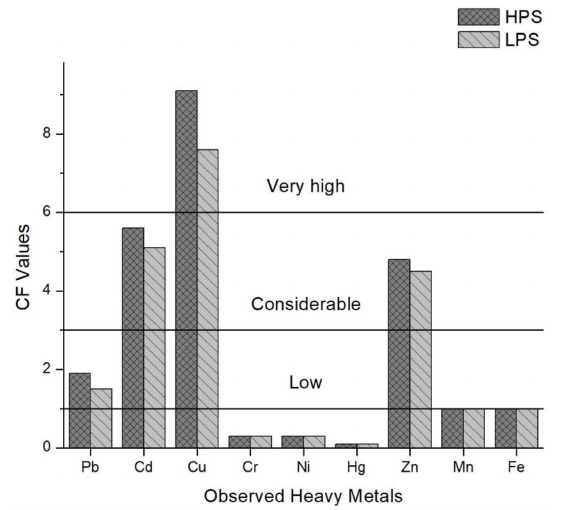
Figure 4. Contamination Factors (CF) of heavy metals in sediments of the samples